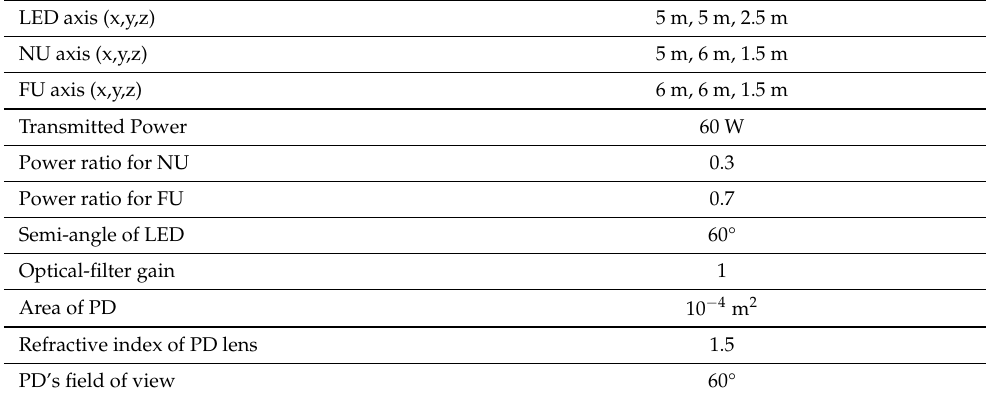
Table 3. Simulation parameters.